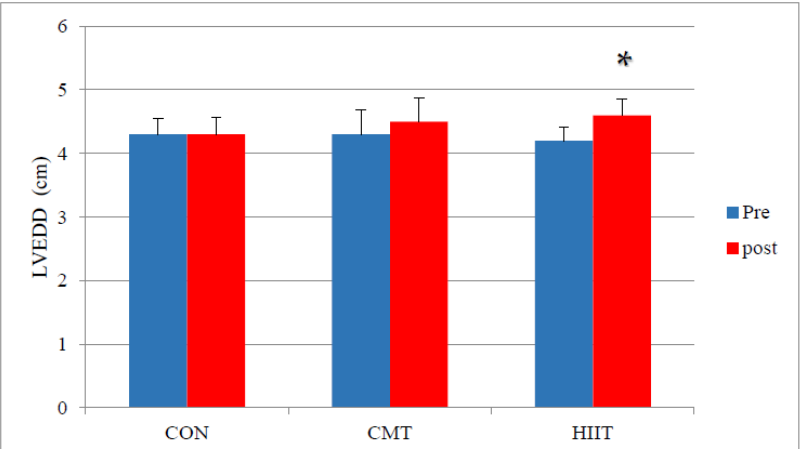
Figure 4. Mean EDD Changes (cm) before and after 12 Weeks of CMT and HIIT; * Indicates a significant increase compared with the CMT and control groups ( p < 0.05). LVEDD: Left Ventricle End-Diastolic Diameter (cm). CON: Control. CMT: Continuous Moderate Training. HIIT: High-Intensity Interval Training.